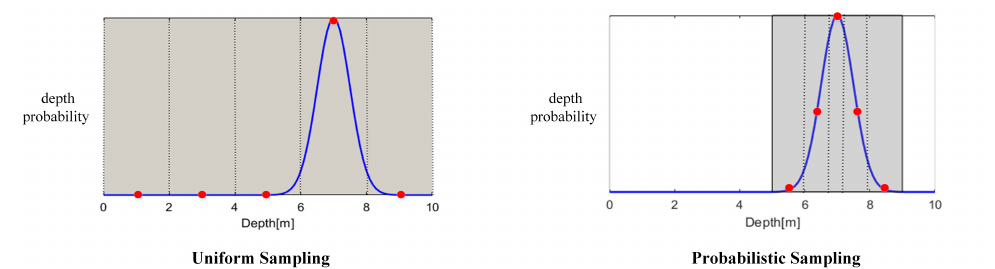
Figure 2. Comparison of uniform and proposed probabilistic sampling methods. The single-view depth probability distribution is represented by the blue curve, and the sampled candidates are represented by the red